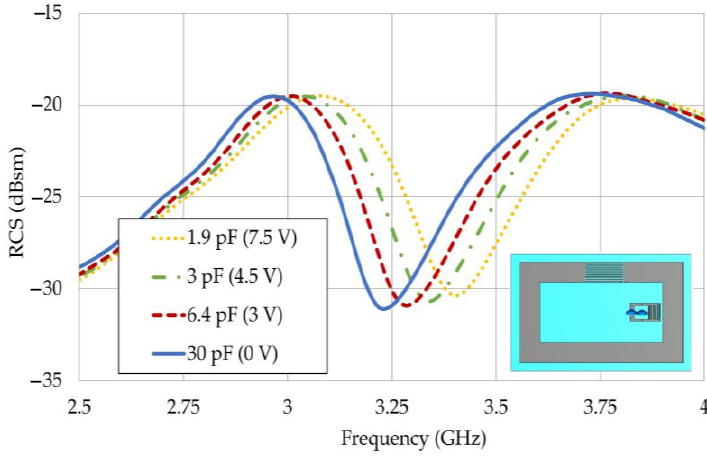
Figure 3. Simulated RCS for different values of varactor capacitances C .